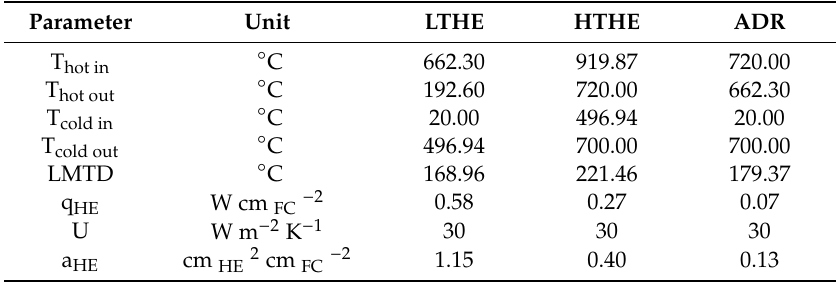
Table 12. Data of the heat